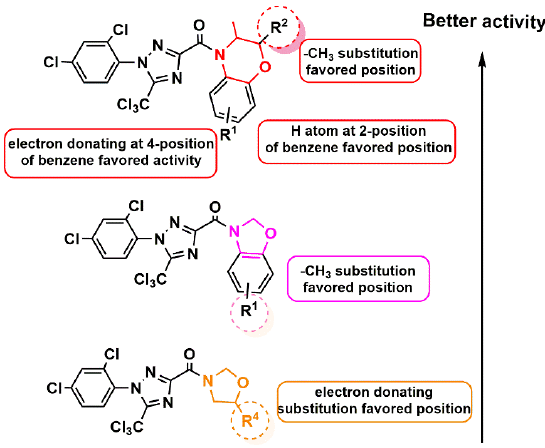
Figure 2. Sequence of activity with different substitution.